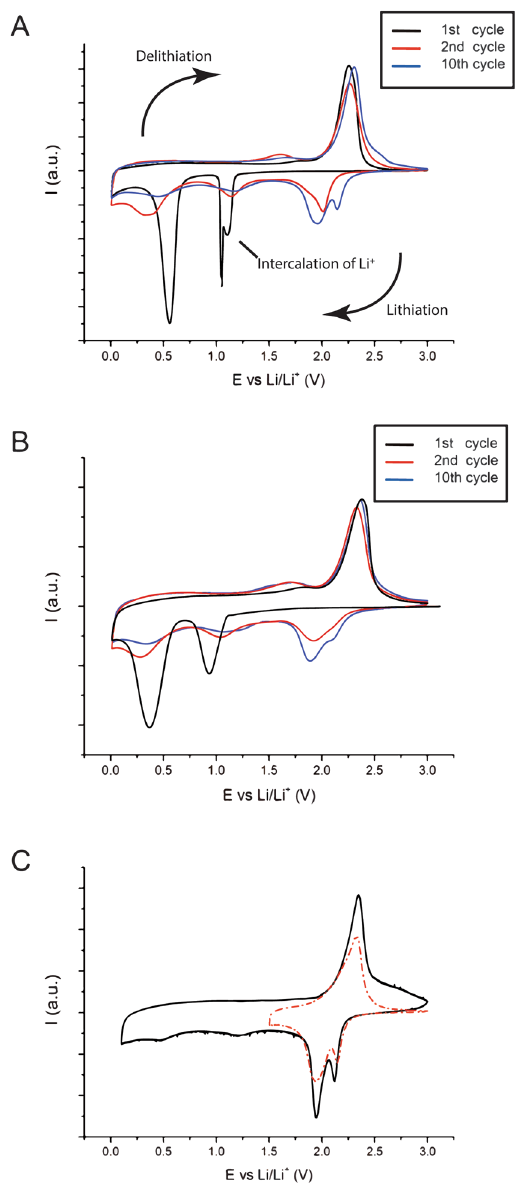
Figure 6. Cyclic voltammograms (1, 2 and 10) at 0.1 mV/s versus Li metal of VA-MoS 2 #1 ( A ) and PO-MoS 2 ( B ); cyclic voltammograms (50) of VA-MoS 2 #1 in wide (black line) and narrow (red line) potential window ( C